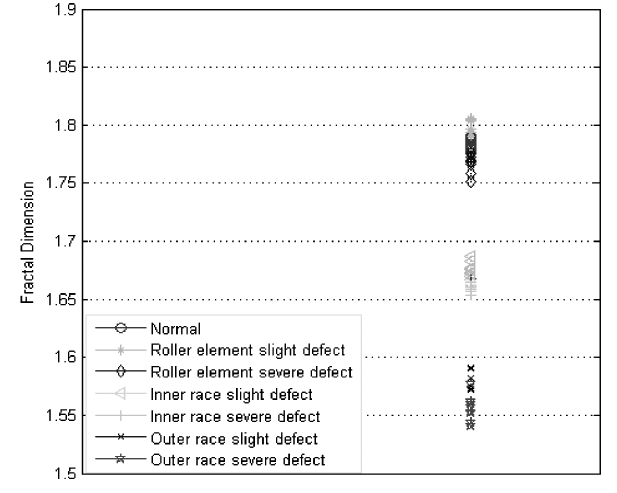
Fig. 5. Single global fractal dimensions of seven bearing states.